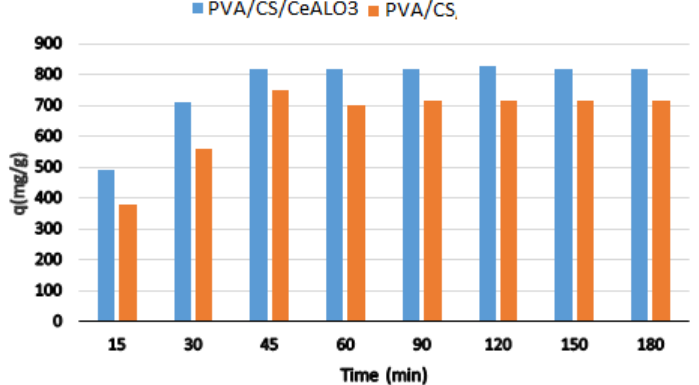
Fig. 9. Effect of contact time on sorption of MB onto PVA/CS and PVA/CS/ CeAlO